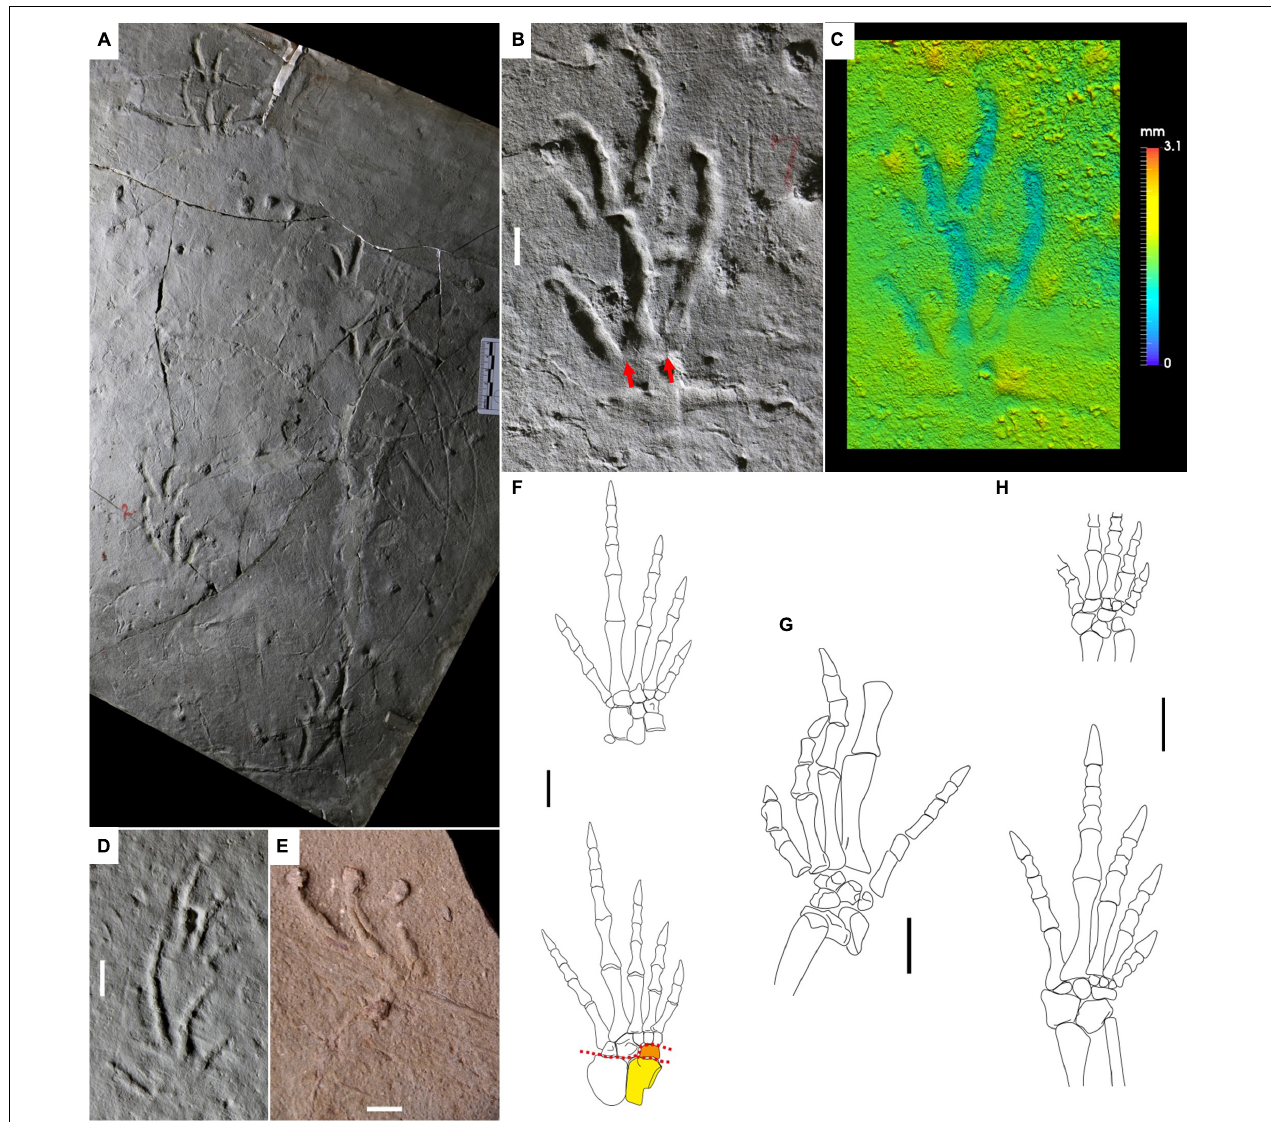
FIGURE 8 | Carboniferous reptile tracks and trackmakers: Dromopus lacertoides (A–E) and araeoscelid (F,G) and non-varanodontine varanopids (H) . (A) YPM 519. Holotype of Dromopus “ agilis. ” Trackway, concave epirelief. Howard Limestone, Kansas. (B) YPM 519. Right pes-manus couple, concave epirelief. Howard Limestone, Kansas. Red arrows indicate the proximal-lateral digit overlap. (C) False-color depth map of (B) . (D) NSM 009 GF 012. Right pes-manus couple, convex hyporelief, plaster cast. Cape John Formation, Nova Scotia. (E) BIRUG BU 5283. Right footprint, convex hyporelief. Enville Member, Salop Formation, United Kingdom. (F) Petrolacosaurus kansensis , reconstruction of left pes and manus, dorsal side. From Reisz (1981), modified. Astragalus in yellow, lateral centrale in orange. Red dotted lines represent the possible articulations within the tarsus. (G) Araeoscelis gracilis , reconstruction of right pes, convex hyporelief. From Reisz et al. (1984), modified. (H) Mesenosaurus romeri , reconstruction of left pes and manus, dorsal side. From Spindler et al. (2019), modified. Scale bars are 1